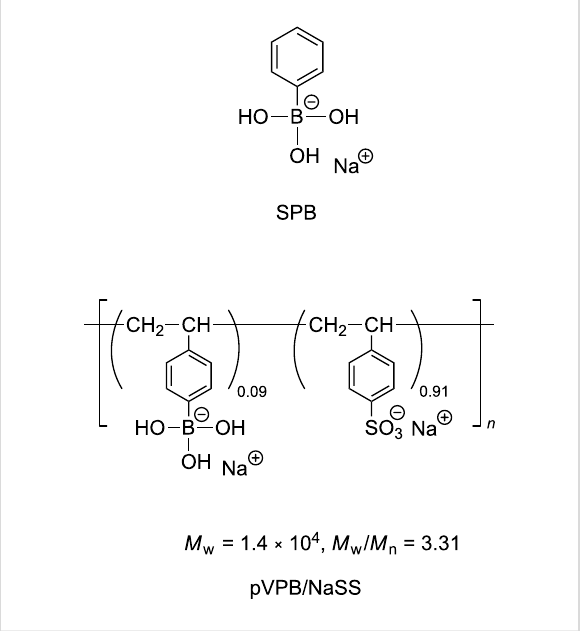
Scheme 1: Structures of the boronic acid compounds used in this study (i.e., SPB and pVPB/NaSS).